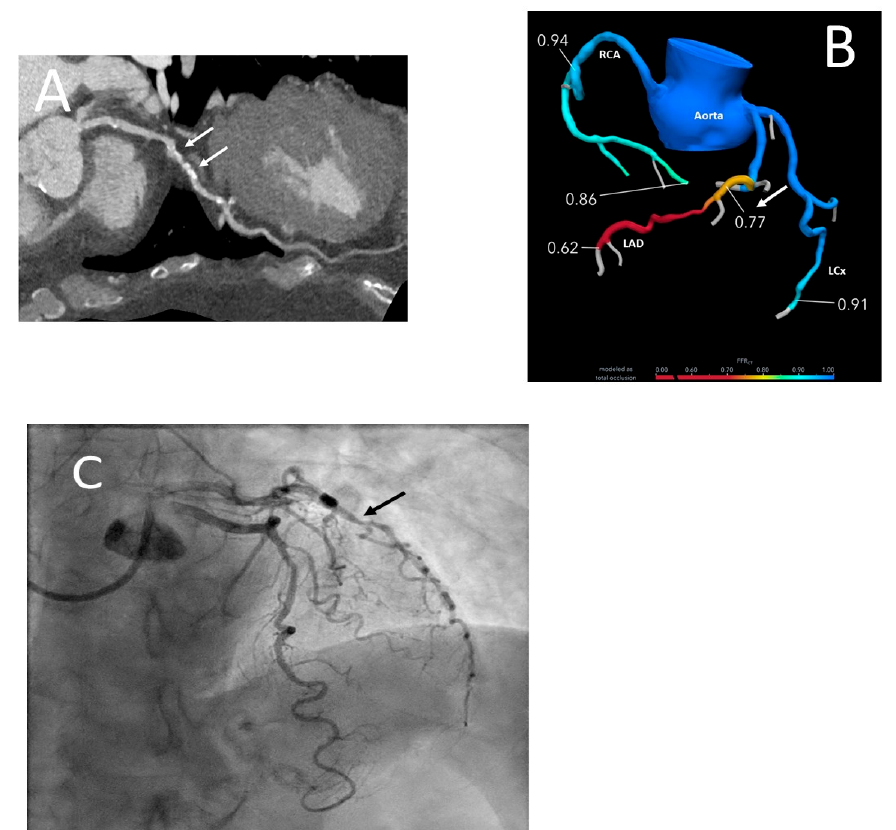
Figure 6. Series shows a CT coronary angiogram with curved planar reformat image ( A ) demonstrat- ing moderate narrowing (arrow) of the proximal-mid left anterior descending coronary artery (LAD). Subsequent CT-fractional flow reserve (CT-FFR; B ) which revealed hemodynamically significant stenosis with a value of 0.77 distal to the area of concern on CT angiogram (>0.80 is considered negative). Catheter angiogram ( C ) showing presence of moderate stenosis in the proximal-mid LAD (black